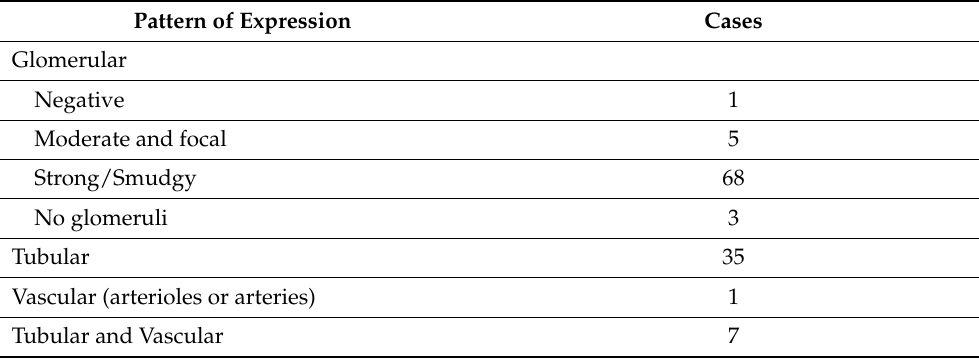
Table 5. DNAJB9 immunohistochemical expression in the FGN